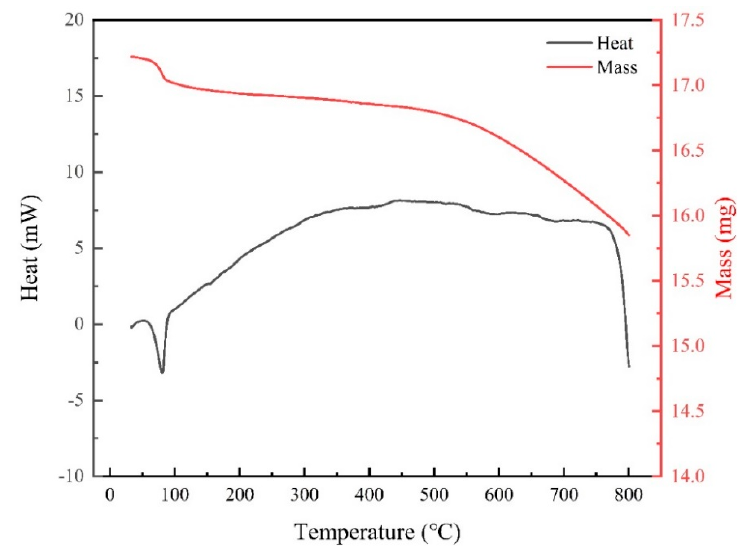
Figure 6. TGA characterization of HCVR during roasting with K 2 CO 3.